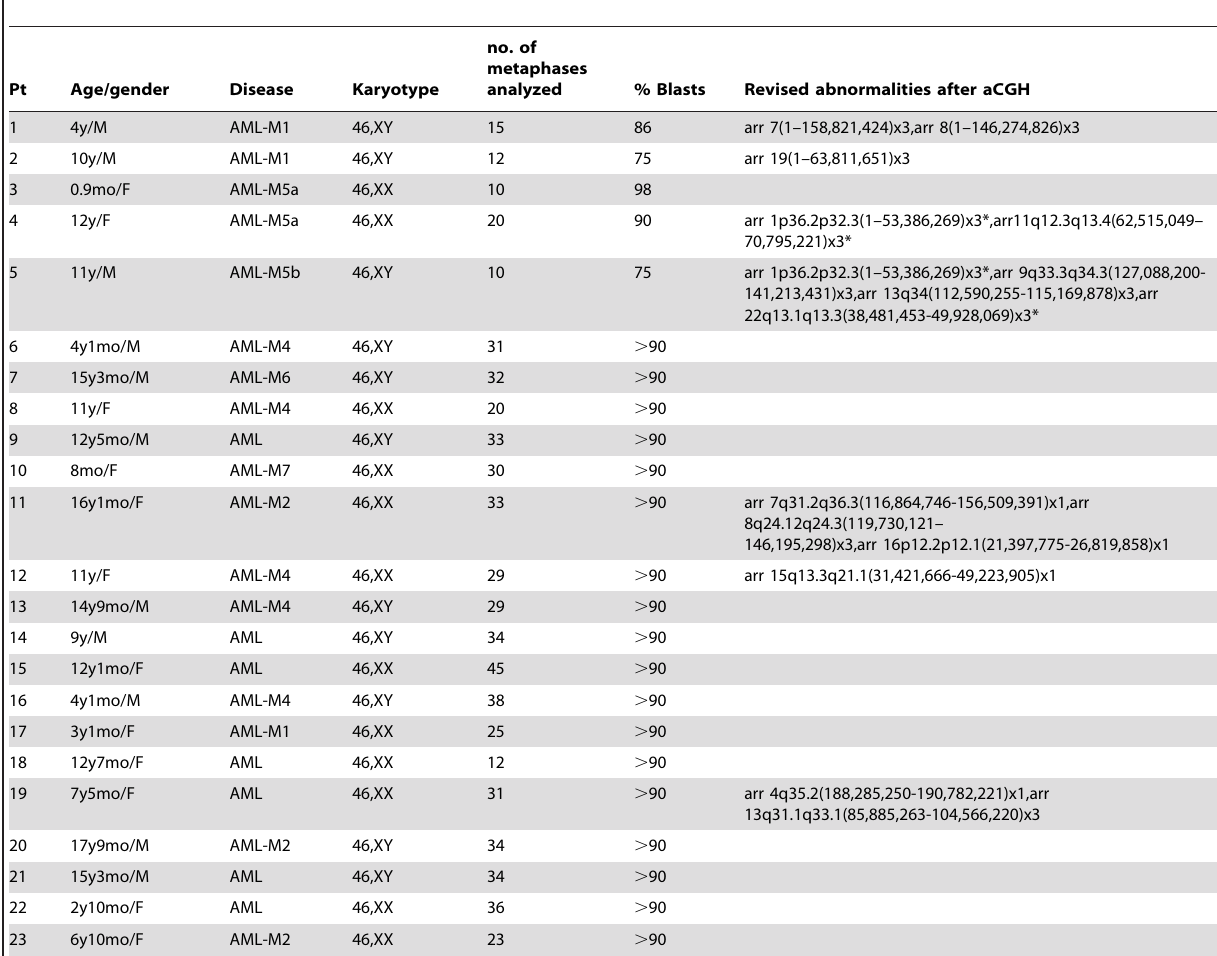
Table 1. Clinical and cytogenetic data of the paediatric and adult patients with AML and no reported chromosomal abnormalities analyzed in the present